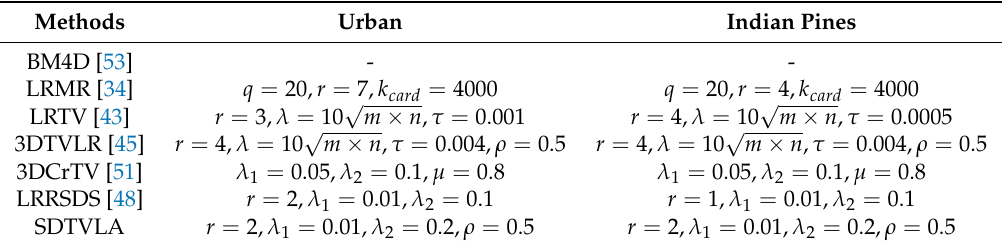
Table 3. Parameters setting of competitive algorithms for the real HSI